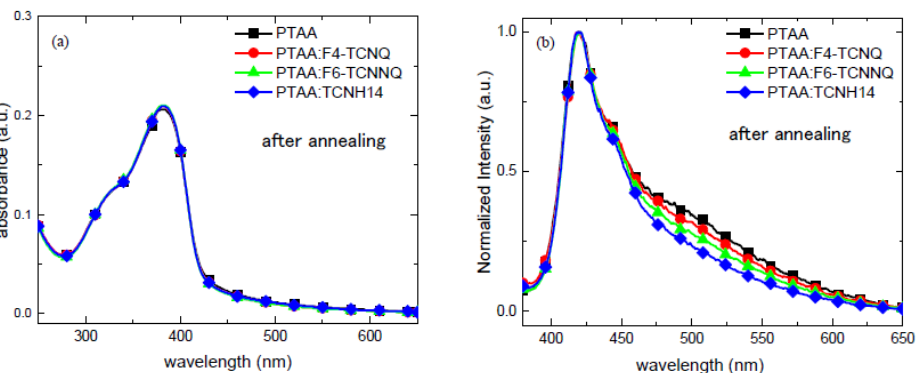
Figure 2. ( a ) UV-Vis absorbance and ( b ) normalized photoluminescence emission of the doped HTL layers with a fixed doping ratio of 96:4 by